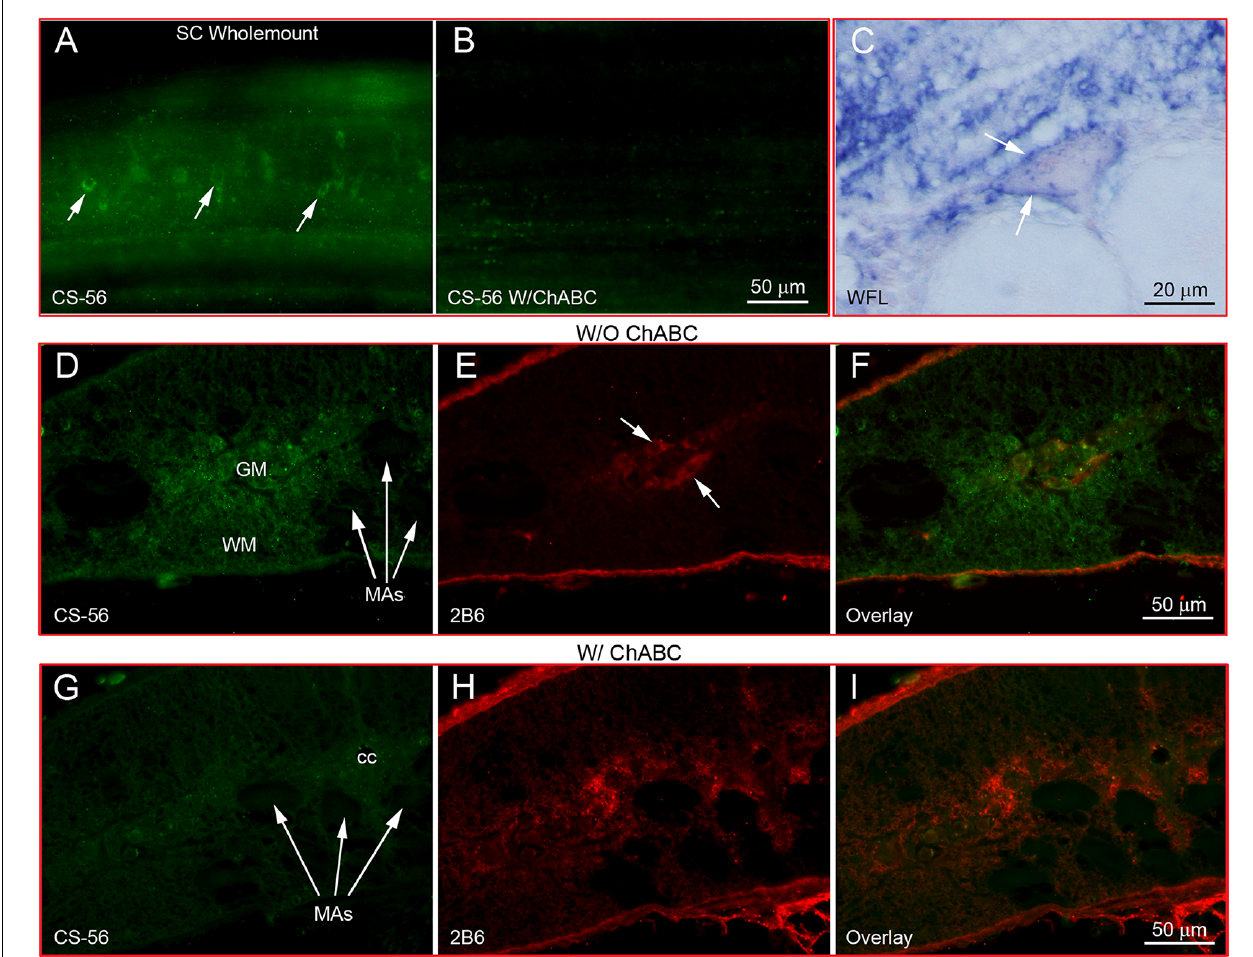
FIGURE 1 | CSPGs are present in lamprey spinal cord and contribute to perineuronal nets. (A) Labeling of CSPGs with antibody CS-56 in SC wholemount shows a perineuronal distribution (arrows). (B) Loss of CSPG labeling after treatment with ChABC. (C) Labeling of lectins by WFL in a transverse section of SC shows the ring structure of PNNs (arrows). (D–F) CSPG immunofluorescence in transverse sections of SC without treatment with ChABC. (D) Intact CSPGs labeled by CS-56. (E) Sparse staining of CSPG stumps with antibody 2B6. (F) Overlay of (D) and (E) . (G–I) As in (D–F) but after treatment with ChABC. CSPGs were broadly distributed in gray matter (GM) and white matter (WM) of normal lamprey SC, but not inside the large Müller axons (MAs). A few SC neurons were labeled by 2B6 before ChABC treatment (arrows in E ), indicating the neuronal distribution of unsaturated disaccharide CSPG core proteins. ChABC treatment dramatically reduced the CS-56 immunoreactivity (G) , while staining for CSPG stumps was increased (H) . (I) Overlay of (G) and (H)